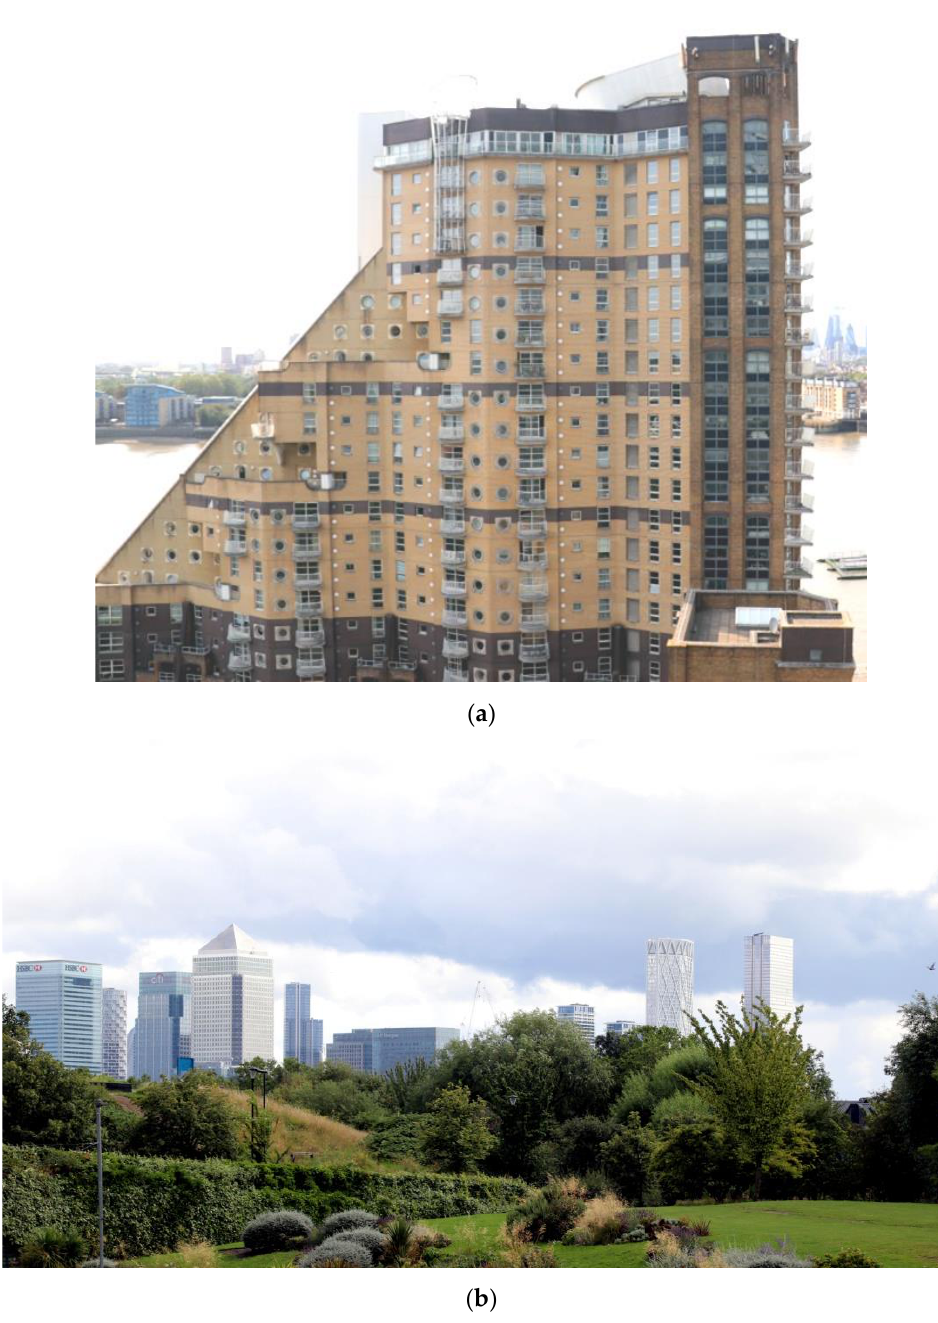
Figure 18. Ascetic approach to colour in the first decades of docklands’ regeneration. ( a ) Toned earthy colours of the Grade II Listed post-modern the Cascades (2020); ( b ) the Isle of Dogs tall building cluster seen from the north demonstrates the ascetic approach to colour in the design of tall buildings, regardless of their use; from the left: 8 Canada Square (office), One Park Drive (residential), 20 Churchill Place (office), One Canada Square (office), South Quay Plaza (residential), Newfoundland (residential), Landmark Pinnacle (residential) (2021).